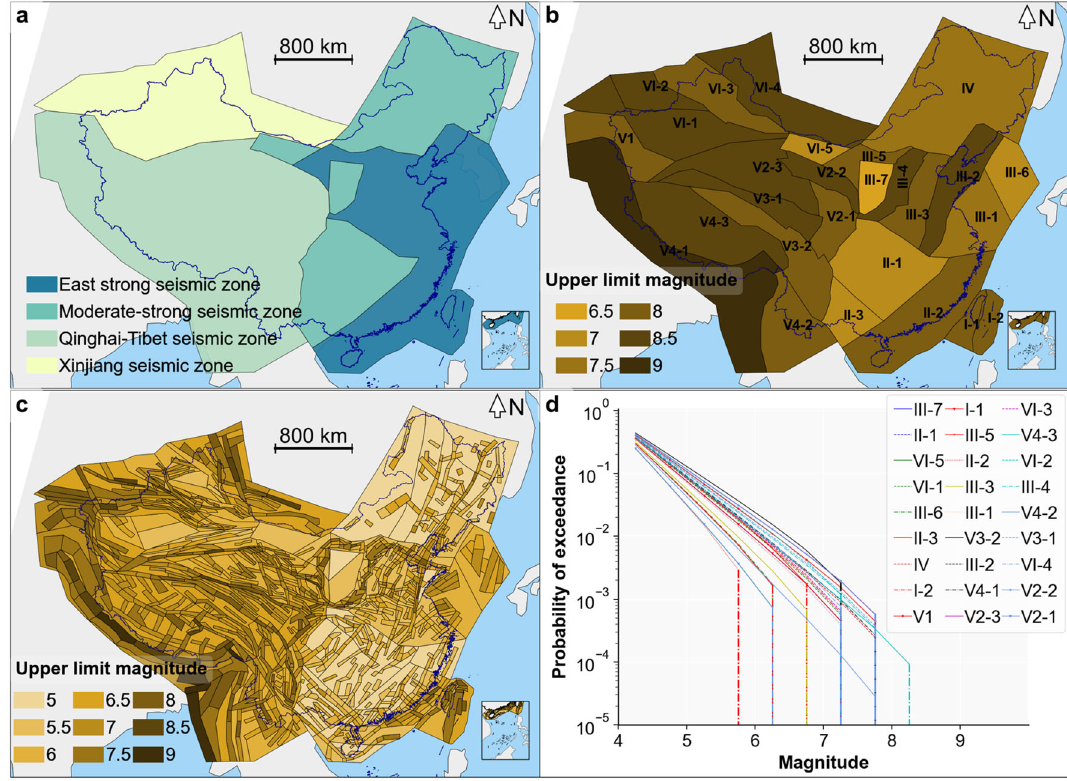
Fig. 2 Chinese probabilistic seismic hazard assessment (CPSHA) seismicity model. a Distribution of seismic zones; b distribution of seismic statistical zones (SSZ); c distribution of potential seismic source zones (PSSZ) and d probability of magnitude exceedance curves for the 27